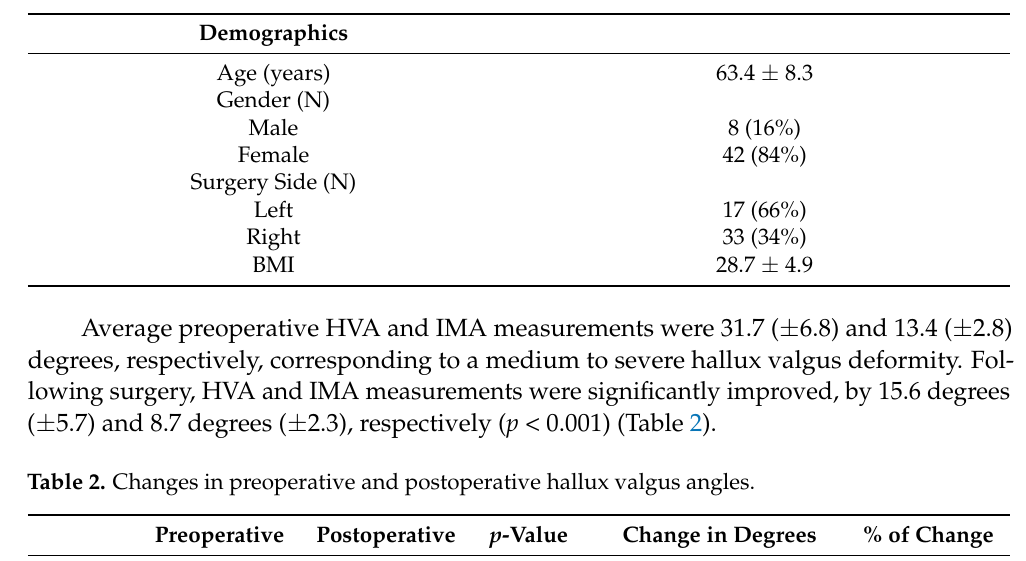
Table 1. Demographics and preoperative measurements.